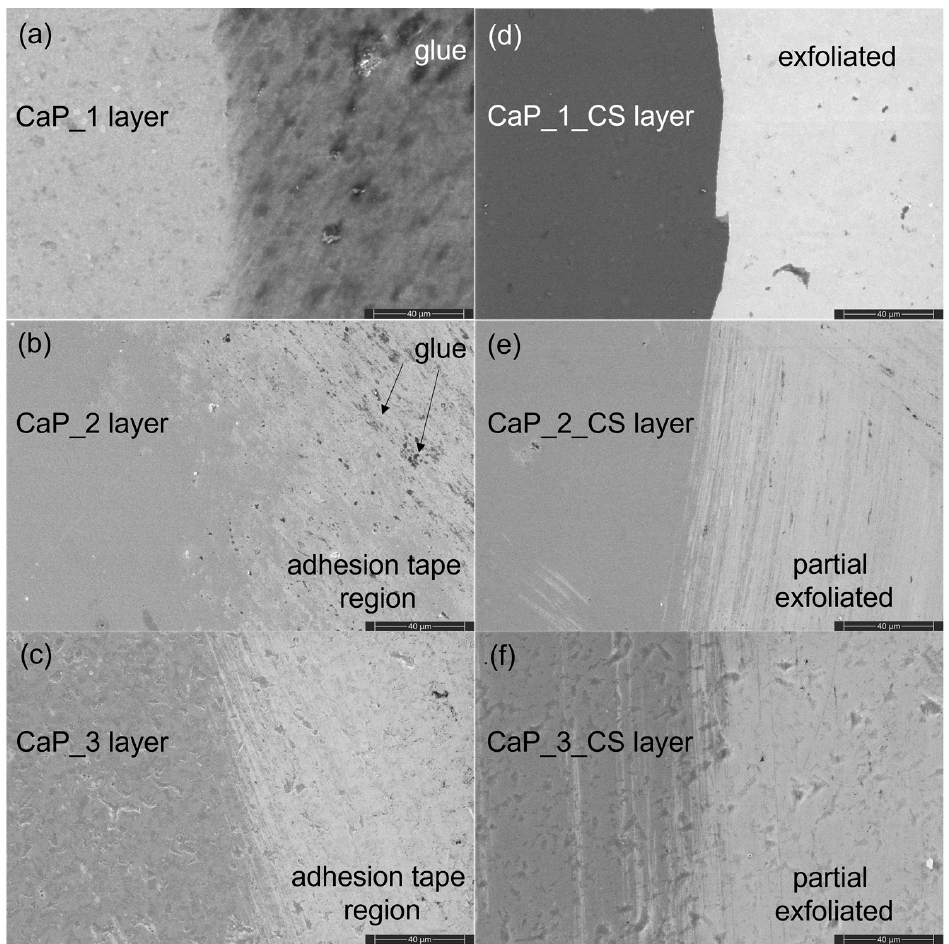
Figure 18. SEM images of ( a ) CaP_1, ( b ) CaP_2, ( c ) CaP_3, ( d ) CaP_1_CS, ( e ) CaP_2 _CS, and ( f ) CaP_3_CS samples after adhesion tests.